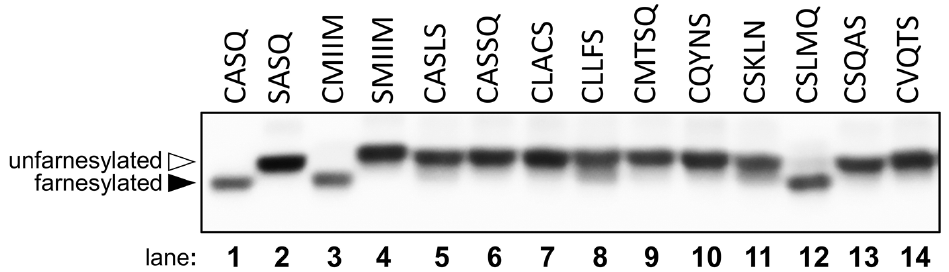
Figure 7. Mobility shift analysis of Ydj1p-CaaaX variants identified from analysis of mammalian genome. Whole cell lysates prepared from yeast expressing the indicated Ydj1p-CaaaX variant were evaluated by SDS-PAGE and anti-Ydj1p immunoblot. The indicated Ydj1p variants were expressed in yWS2544 (ydj1::KANR) to eliminate any contribution from naturally encoded Ydj1p. Farnesylated Ydj1p (i.e., CASQ and CMIIM; closed triangle) exhibited a smaller apparent molecular mass relative to unmodified Ydj1p (i.e., SASQ and SMIIM; open triangle). Farnesylation profiles for the indicated Ydj1p-CaaaX variants were determined across multiple technical replicates, from which the percent of farnesylated species relative to the total signal for a sample was determined (see Figures S13 and S14 and Table